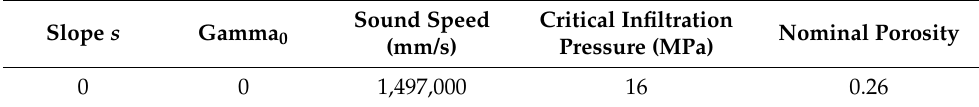
Table 1. Parameter settings of Fluka 100-C 8 silicone gel nanofluidic system.